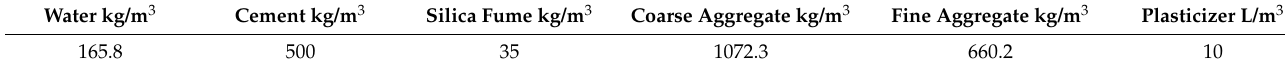
Table 5. HPC M60 mix proportion.